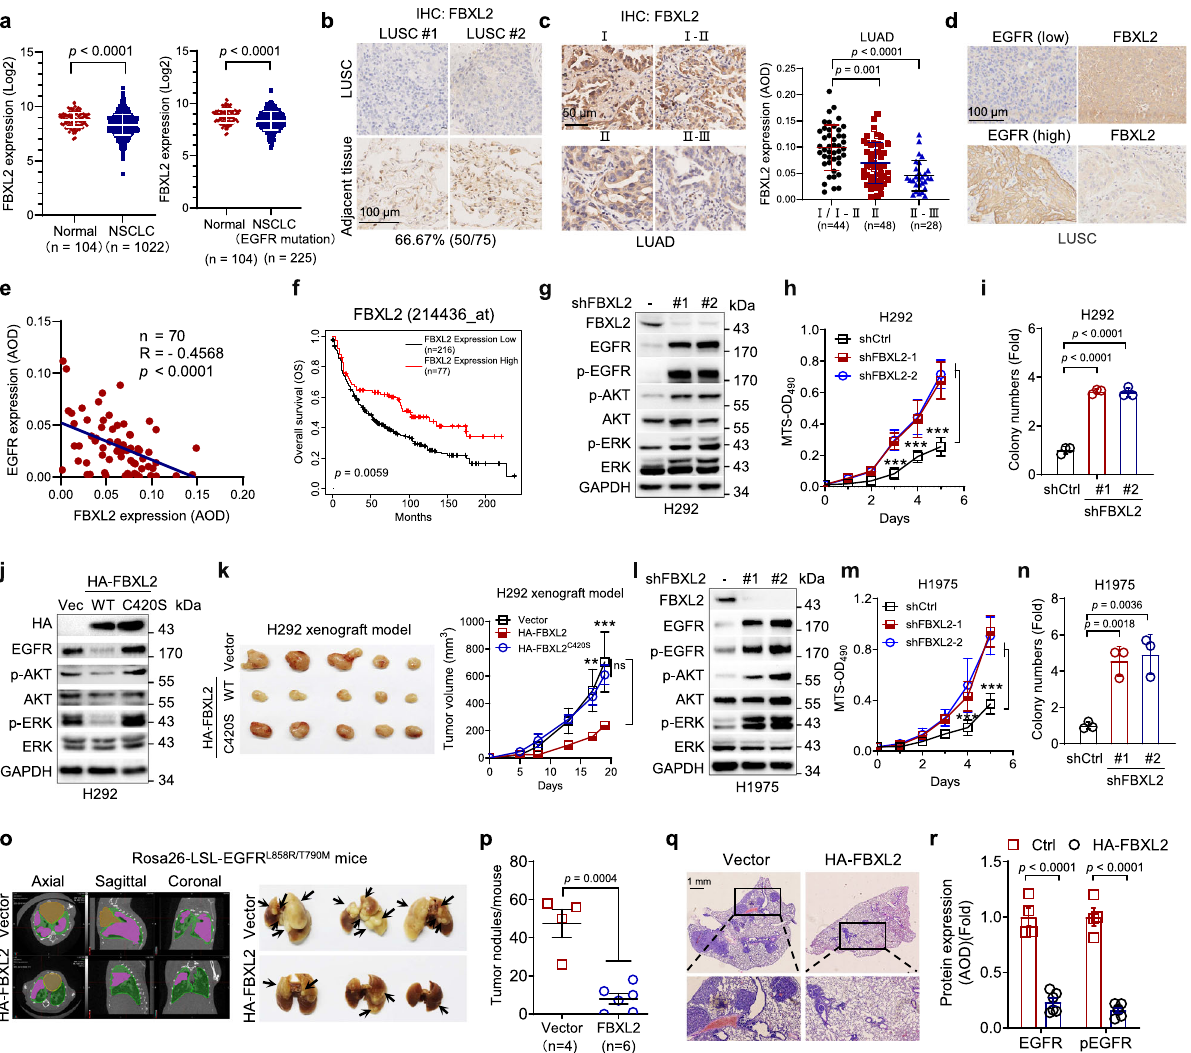
Fig. 3 FBXL2 inhibits EGFR-overexpressed or EGFR L858R/T790M -driven NSCLC growth and the expression of FBXL2 and EGFR is reversely correlated. a The mRNA levels of FBXL2 in NSCLC ( n = 1022) or NSCLC with EGFR mutations ( n = 225) and normal lung tissues ( n = 104) were analyzed using the TCGA database (LUAD and LUSC). b Tissue microarray slides derived from LUSC ( n = 75 pairs of tumors and adjacent samples) were subjected to IHC analysis. Representative images of IHC staining were shown. c Tissue microarray slides derived from LUAD ( n = 120) were subjected to IHC analysis. Representative images of IHC staining were shown. Staining was quanti fi ed by AOD. d , e Consecutive tissue microarray slides derived from LUSC were subjected to IHC assay for EGFR and FBXL2 expression and analyzed for Pearson correlation. Staining was quanti fi ed by AOD. f Kaplan − Meier plots of overall survival (OS) of human lung cancer patients were strati fi ed by the FBXL2 mRNA levels in the patient tumor samples. H292 cells stably expressing shRNAs against FBXL2 were subjected to g Western blot analyses, h MTS assays, or i colony formation assays. Three independent experiments were performed. H292 stable cells were subjected to j Western blot analyses or k xenograft tumor growth assays ( n = 5/group). Photos of tumors and growth curves were presented. ** p = 0.0063, *** p = 0.00025. H1975 cells stably expressing shRNAs against FBXL2 were subjected to l Western blot analyses, m MTS assays, or n Colony formation assays. Three independent experiments were performed. o − r Rosa26-LSL-EGFR L858R/T790M mice were used to assess the effects of FBXL2 on EGFR T790M -mediated TKI resistance ( n = 4 or 6/group). o Representative micro-CT images and photos of the lung were shown. Khaki, green, or purple-red represents heart, lung, or tumors, respectively. p The numbers of observable nodules in the lung surface were presented. Paraf fi n-embedded lungs were sectioned and subjected to either q H&E staining or r IHC analyses. Data were quanti fi ed by AOD. Data were presented as means ± SD ( a , c , h − i , and m , n ) or means ± SEM ( k , p , and r ). * p < 0.05, ** p < 0.01, *** p < 0.001; by two-tailed Student ’ s t -test. Source data are provided as a Source data fi